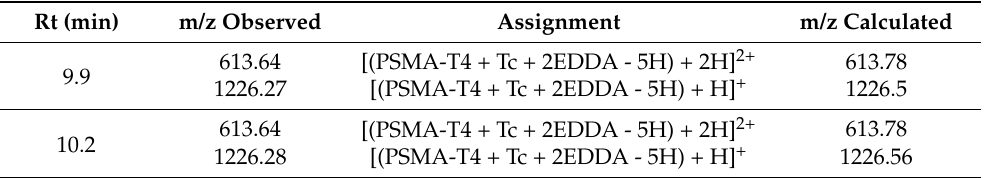
Table 1. LC-MS data for [ 99/99m Tc]Tc-PSMA-T4 complex. Rt (min) m/z